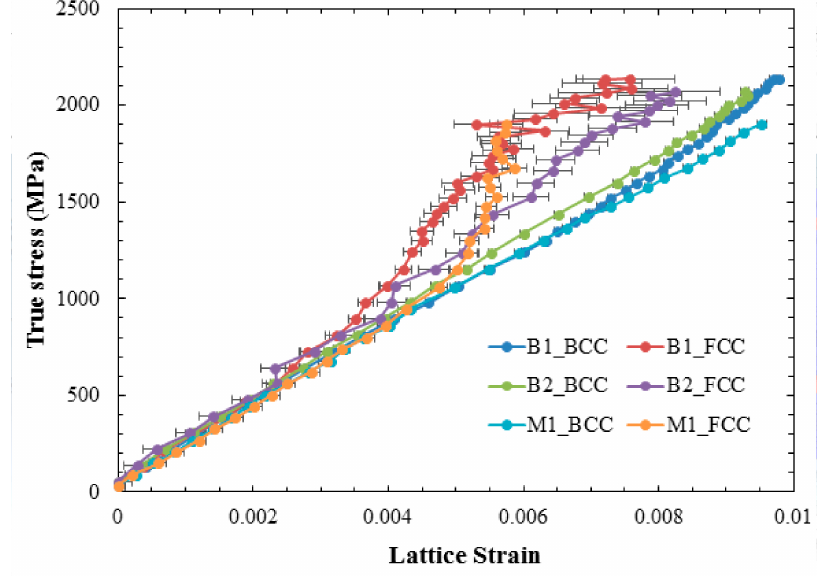
Figure 5. Lattice strain plot for the three specimens evaluated from in situ neutron di ff